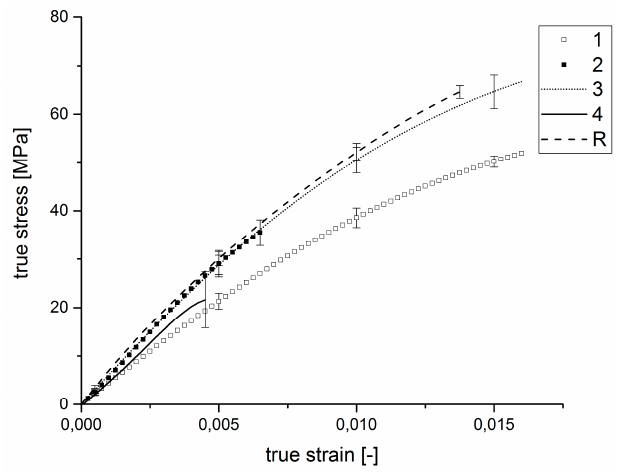
Figure 13. Average stress-strain diagram of the internal pressure tests for the samples influenced by the injection molding parameters.